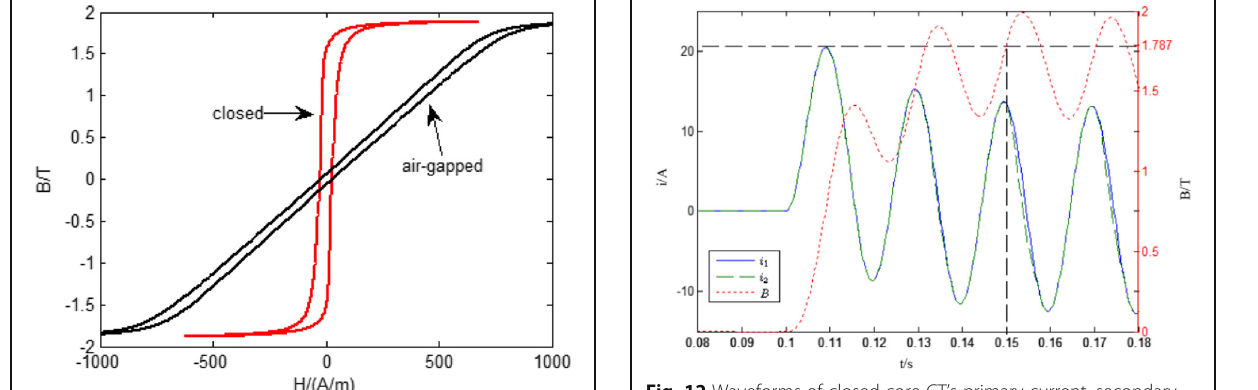
Fig. 12 Waveforms of closed-core CT ’ s primary current, secondary current and magnetic flux density